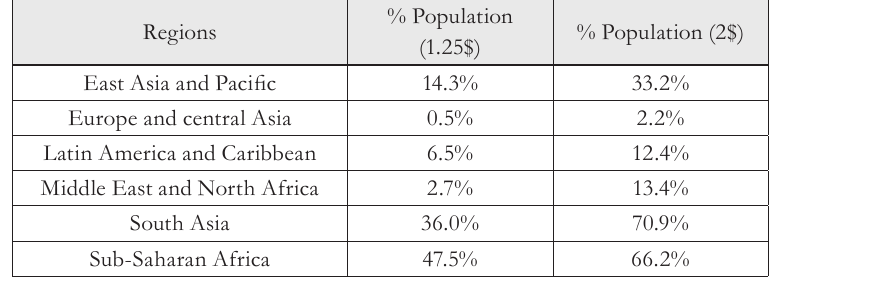
Tab. 2 - Poverty head count ratio at $1.25 and $2 a day (PPP) in 2008. Source: World Bank (www.